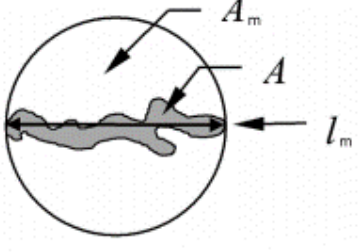
Figure 1. Diameter measuring method where the nodule was circumscribed within a circle with diameter l m and area A m ; the nodule area is A